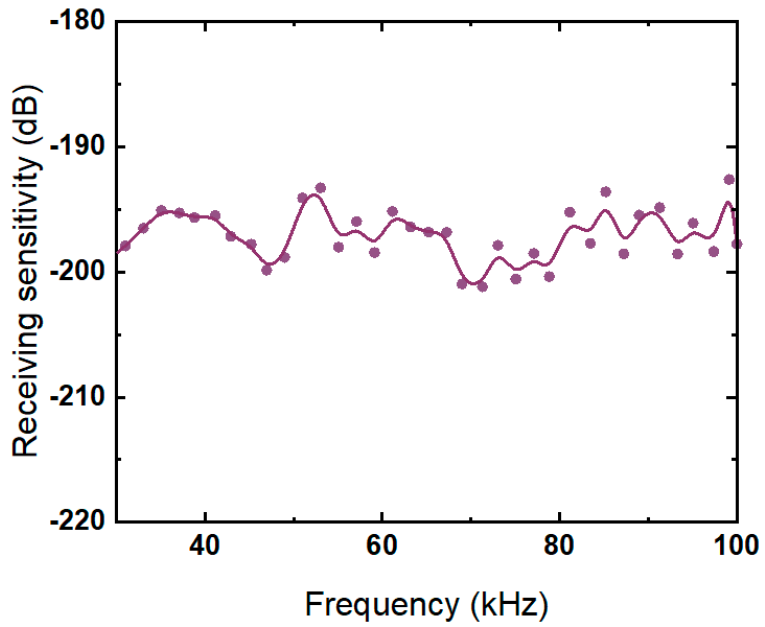
Figure 15. Receiving sensitivity of the transducer array.